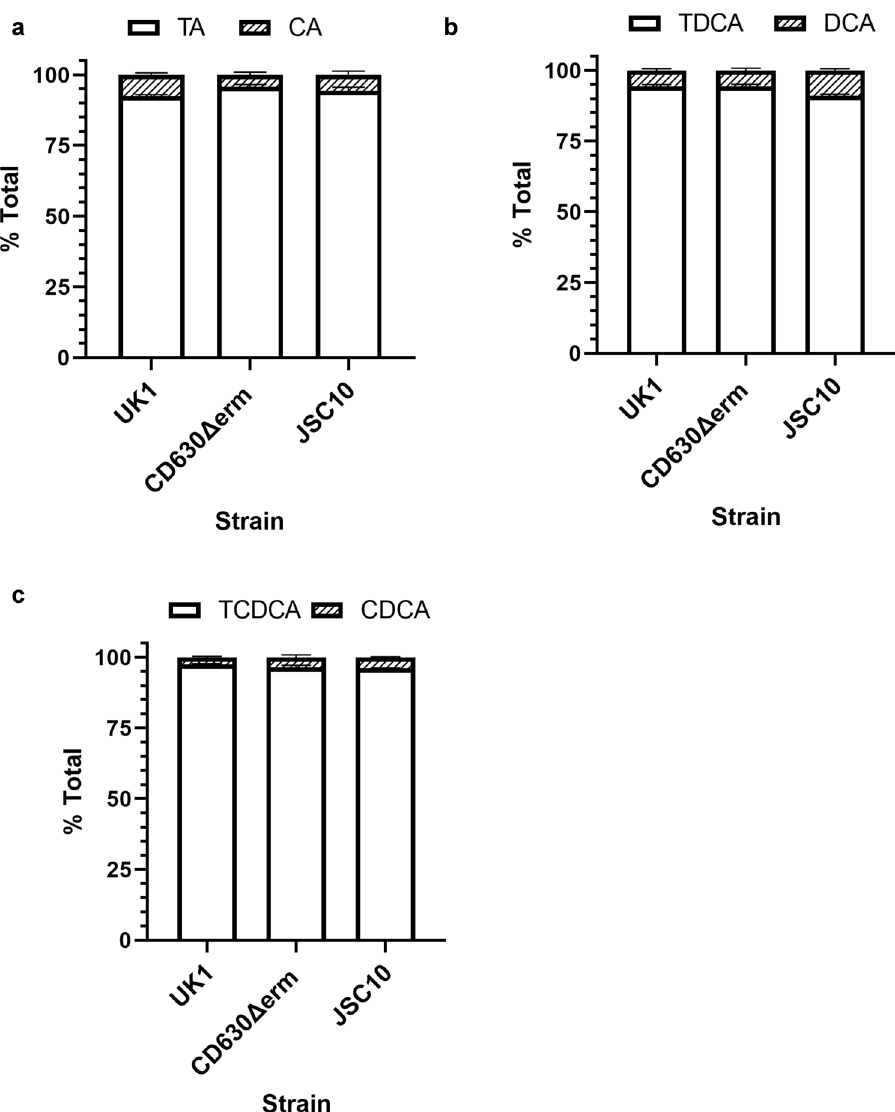
Fig. 5 C. dif fi cile spores show low levels of BSH activity toward taurine-derived bile acids. Totally, 1.2 × 10 9 spores were incubated for 24 h in an aerobic environment at room temperature in phosphate buffer saline (PBS) supplemented with a 1 mM TA, b 1 mM TDCA, and c 1 mM TCDCA. Samples were centrifuged, and fi lter sterilized. Bile salts were measured using HPLC. Values were calculated by measuring the peak areas for the indicated bile salt and expressed as a percentage of the total input. HDCA was included as an internal standard. Values shown are the average of three different independent experiments, and error bars represent the standard error of the